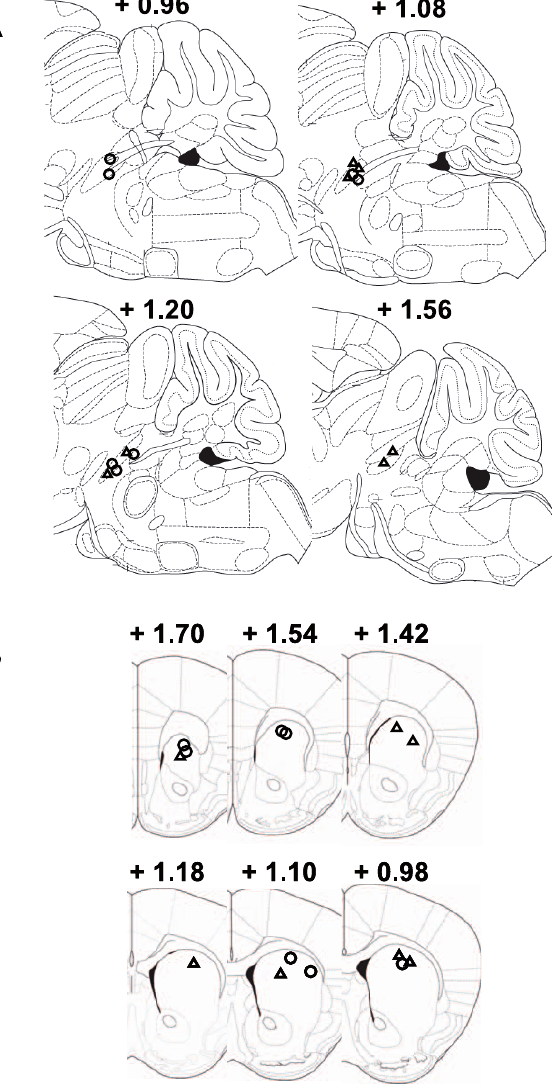
Figure 3. PPT stimulation sites (A) and striatal recording sites (B) used in Experiment 2. (A) Sagittal sections of the mouse brain showing tip placements of PPT stimulating electrodes in wildtype (open triangles, n=7) and M 5 knockout (open circles, n=7) mice. Numbers above individual sections indicate lateral distance in mm from the midline. (B) Coronal sections of the mouse brain showing tip placements of recording electrodes in wildtype (open triangles, n=7) and M 5 knockout (open circles, n=7) mice. Numbers above individual sections show distance in mm from bregma. Sections are adapted from the atlas of Paxinos and Franklin [38].